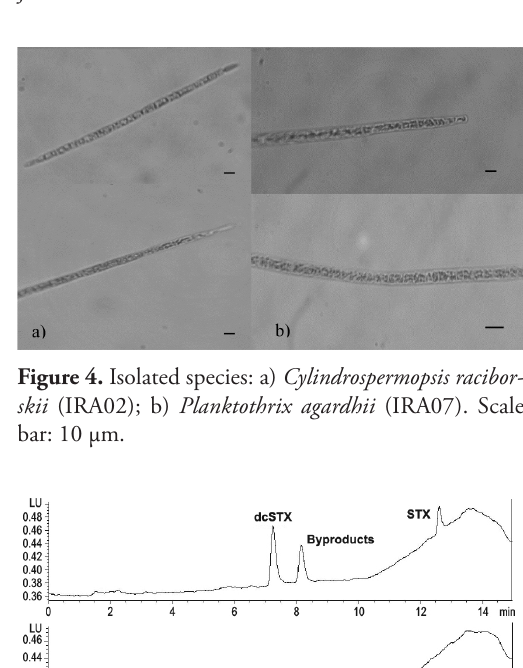
Figure 3. Distribution of phytoplankton groups in Sítios Novos Reservoir (Ceará, Brazil) from January 2010 to June 2011.